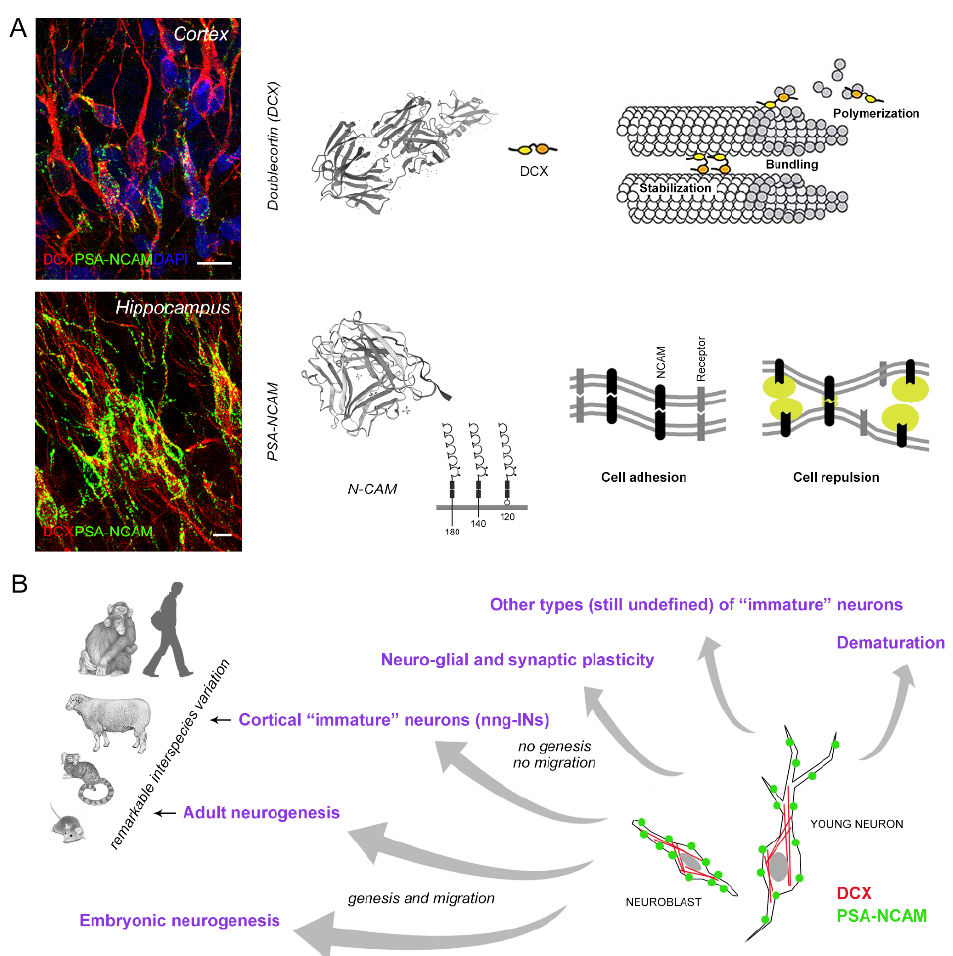
Figure 3. ( A ) Two molecules defining neuronal immaturity and most used as immunocytochemical markers for studying different forms of plasticity, including neurogenesis, adult neurogenesis and “immature” neuron detection. Doublecortin is a cytoskeletal protein involved in multiple structural changes of the cells; PSA-NCAM is an anti-adhesive, membrane-bound protein endowed with polymers of sialic acid on the extracellular domain. Scale bars, 10 µ m. ( B ) DCX and PSA-NCAM are frequently co-expressed in cell populations associated with biological processes spanning a very wide spectrum, from neurogenesis to senescence. For this reason, these markers (if used alone, for instance, not in association with other –, e.g., cell proliferation markers) cannot specifically identify one of these processes. In addition, though sharing the same markers, some plastic cell populations remarkably vary in their amount and distribution depending on animal species among